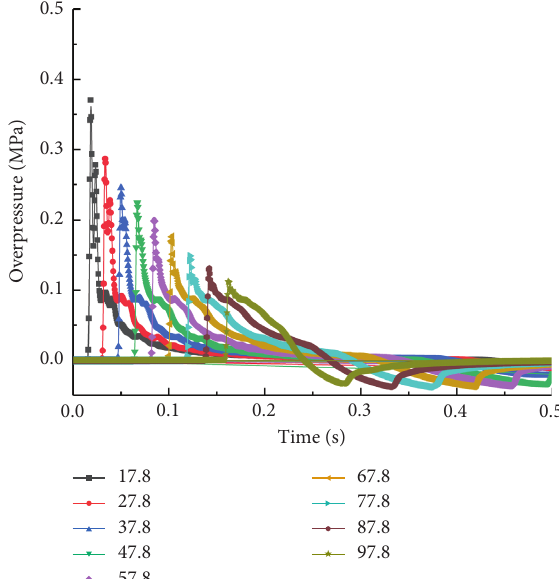
Figure 5: Overpressure change graph of each measuring